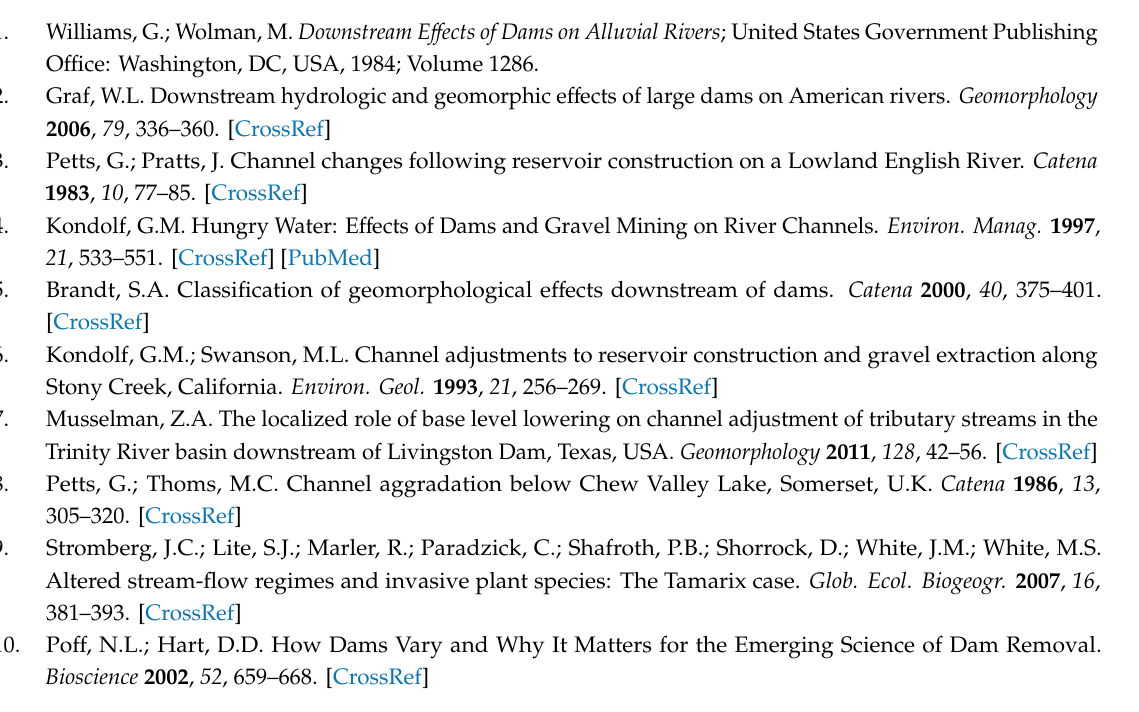
Figure S1: The Tekeze dam operation and management is based on an information supported decision support system (DSS): reservoir water levels are monitored but the dam operator makes all decisions (McCartney and King, 2011, [16]); Figure S2 The post-dam river narrowing has mainly occurred in the areas with a large pre-dam river width (unconfined areas) than in those with a smaller pre-dam river width (confined areas); Figure S3: Banana plants damaged by the 2018 emergency dam release: the yellow-colored plants will die and need to be replaced. The water levels remained high for up to fifteen days and thick layers of sand have been